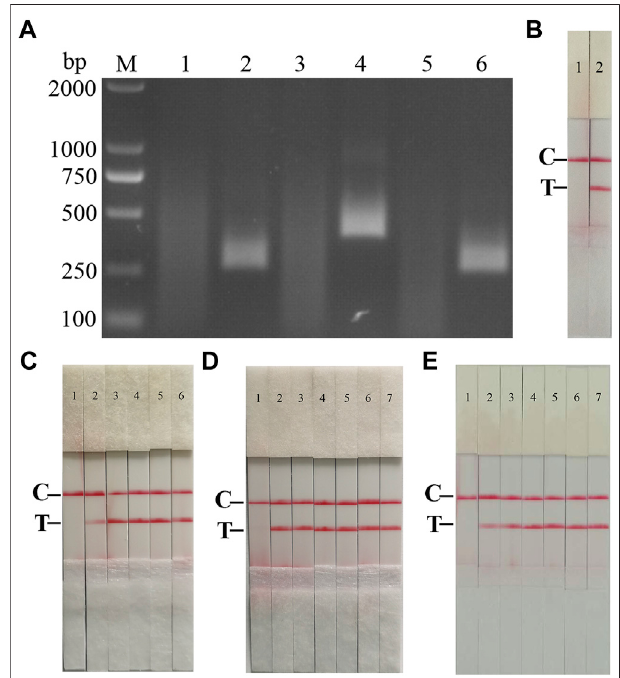
FIGURE 2 | Establishment of AFSV RAA-Strip and Optimization of the Reaction Condition. (A) Optimal primer selection. The products ampli fi ed by different RAA primers were analyzed by 1.5% agarose gel electrophoresis to select the optimal primer pairs. M is a 2,000 bp DNA marker. The primers and templates used in lane 1 – 6 successively are: ASFV-RAA-F1/ R1+ddH 2 O, ASFV-RAA-F1/R1+ASFV, ASFV-RAA-F2/R2+ddH 2 O, ASFV- RAA-F2/R2+ASFV, ASFV-RAA-F3/R3+ddH 2 O, and ASFV-RAA-F3/ R3+ASFV. (B) Initial development of the ASFV RAA nucleic acid strip assay. Using the recombinant plasmid pMD19-T-p72 as a template to test the ASFV RAA-strip.Cisacontrolline.Tisatestline.Thetemplates usedinlane1and2 successively are the negative control and the ASFV pMD19-T-p72. (C) The determination of the optimal reaction temperature range of ASFV RAA-strip. The temperature of templates used in lane 2 – 6 successively are 25, 30, 35, 40, and 45 ° C. (D) The detection of the accurate optimal temperature. The temperatureoftemplatesusedinlane2 – 7successivelyare35,36,37,38,39, and 40 ° C. (E) Optimization of reaction time. Using the recombinant plasmid pMD19-T-p72 as a template to optimize the ampli fi cation time of ASFV RAA- strip. Line 1 is a negative control. The reaction time of templates used in lane 2 – 7 successively are 5, 10, 15, 20, 25 and 30